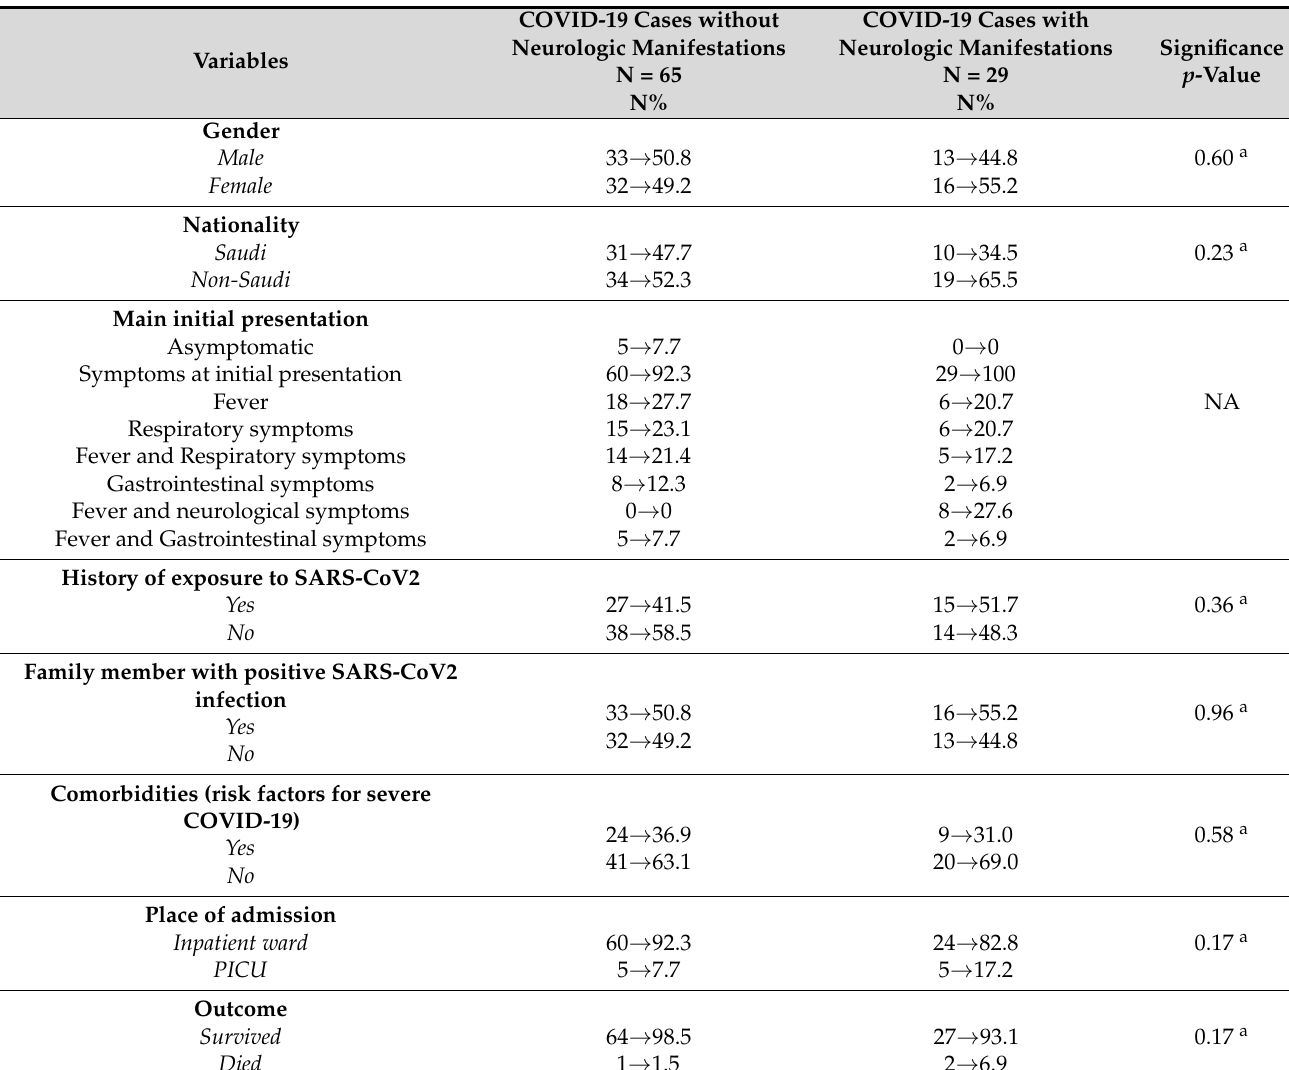
Table 3. Comparison of clinical data between pediatric COVID-19 cases with and without neurologi- cal